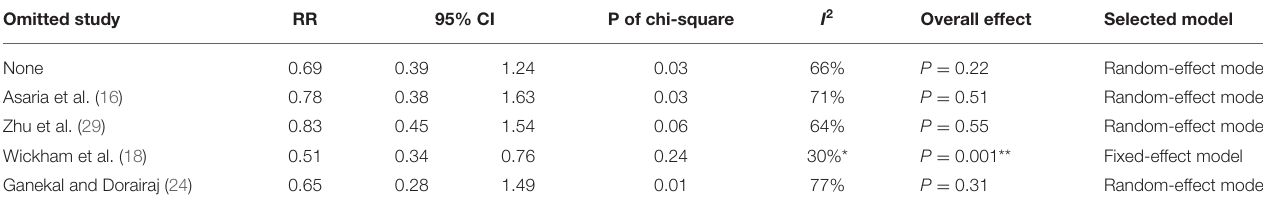
TABLE 4 | Sensitivity analysis for main outcome: postoperative PVR occurrence.